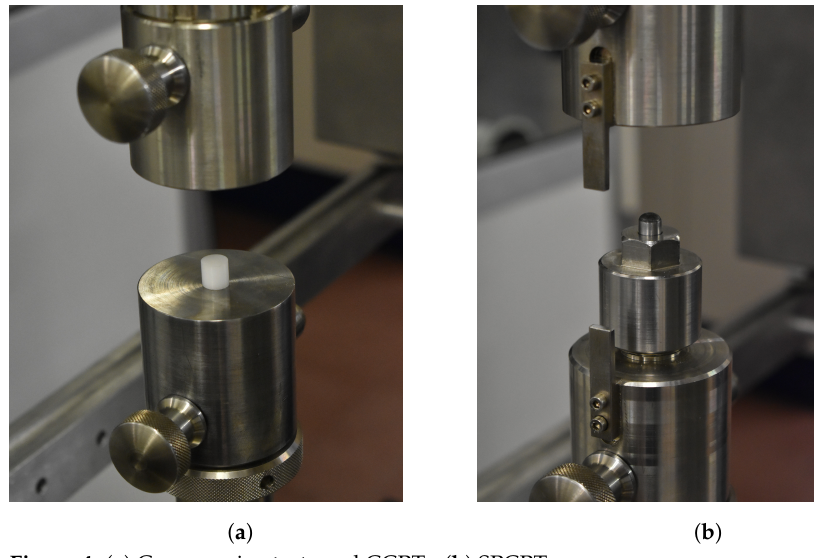
Figure 4. ( a ) Compressive tests and CCRTs, ( b )